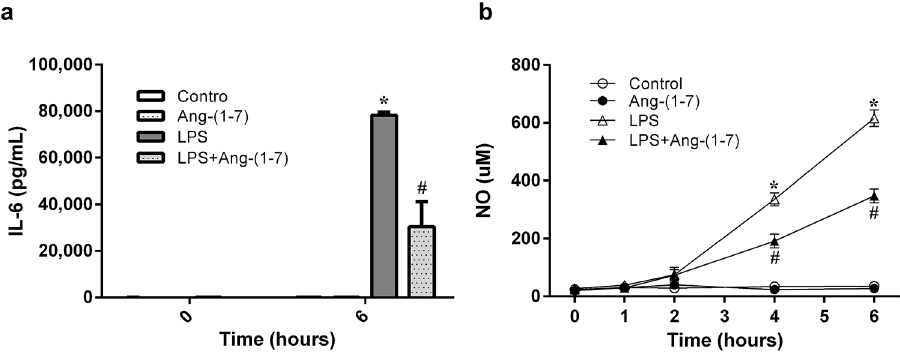
Figure 4. Angiotensin-(1–7) attenuates the elevated plasma levels of interleukin-6 and nitric oxide in endotoxaemic rats. We assessed the changes in interleukin (IL)-6 ( a ) in rats infused with 0.9% NaCl (control, n = 6), angiotensin (Ang)-(1–7) (1 mg/kg for 3 h, n = 6), E. coli lipopolysaccharide (LPS, 10 mg/kg for 15 min, n = 6), or LPS plus Ang-(1–7) (1 mg/kg for 3 h at 0.5 h after LPS, n = 6); or the changes in NO ( b ) during the experimental period in control (n = 6), Ang-(1–7) (n = 6), LPS (n = 12), or LPS + Ang-(1–7) (n = 12) rats. The data are shown as the mean ± standard error of the mean. *, p < 0.05 for LPS vs. control. # , p < 0.05 for LPS + Ang- (1–7) vs.